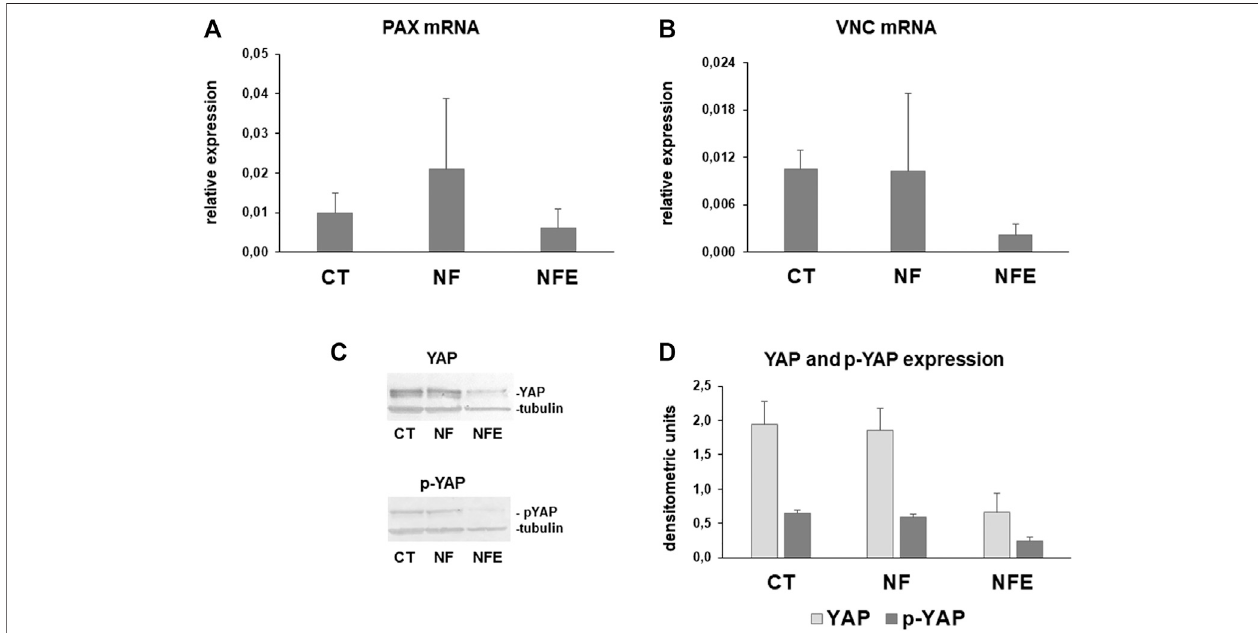
FIGURE 7 | Bar graphs showing PAX (A) and VNC (B) mRNA levels in HGF after normalization on GAPDH gene expression. Data are means for at least two independent experiments. (C) Representative Western blot for YAP and inactive phosphorylated p-YAP (D) . Bar graphs showing YAP and p-YAP assayed by Western blot in whole cell lysates after densitometric analysis of immunoreactive bands. Data are mean ± SD for at least two independent